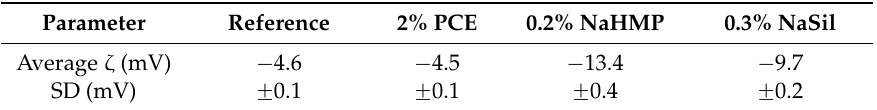
Figure 5. Adsorption isotherm for the PCE molecules reported with respect to the added PCE. The dotted line indicates full consumption. Table 3. ζ -potential values for the reference earth, the earth prepared with 2% PCE, the earth prepared with 0.2% NaHMP and the earth prepared with 0.3%